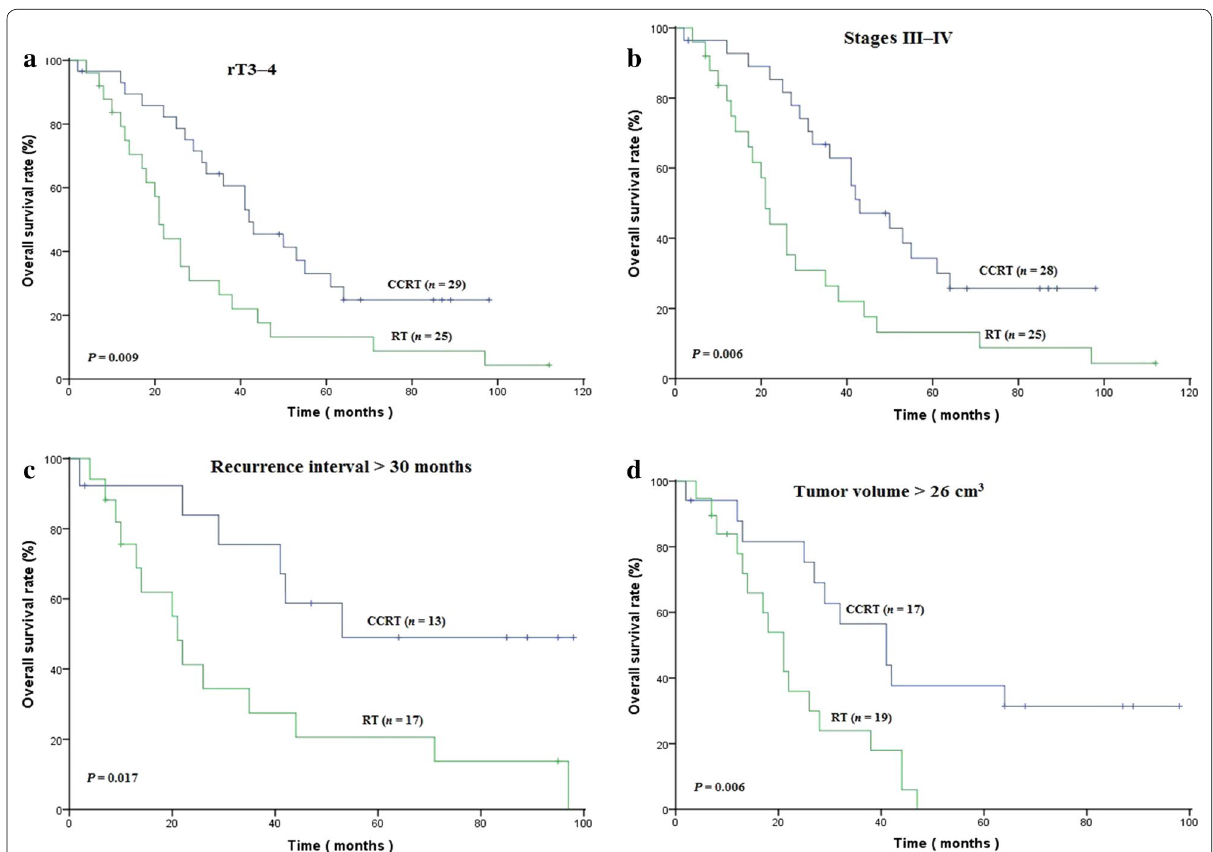
Fig. 2 Kaplan–Meier curves of overall survival in distinct subgroups of NPC patients treated with CCRT or RT. The results show that CCRT signifi‑ cantly improved the 5‑year overall survival rate for patients with a rT3–4 category disease (33.0% vs. 13.2%, P vs. 13.2%, P 0.006), c recurrence interval >30 months (49.0% vs. 20.6%, P = compared with